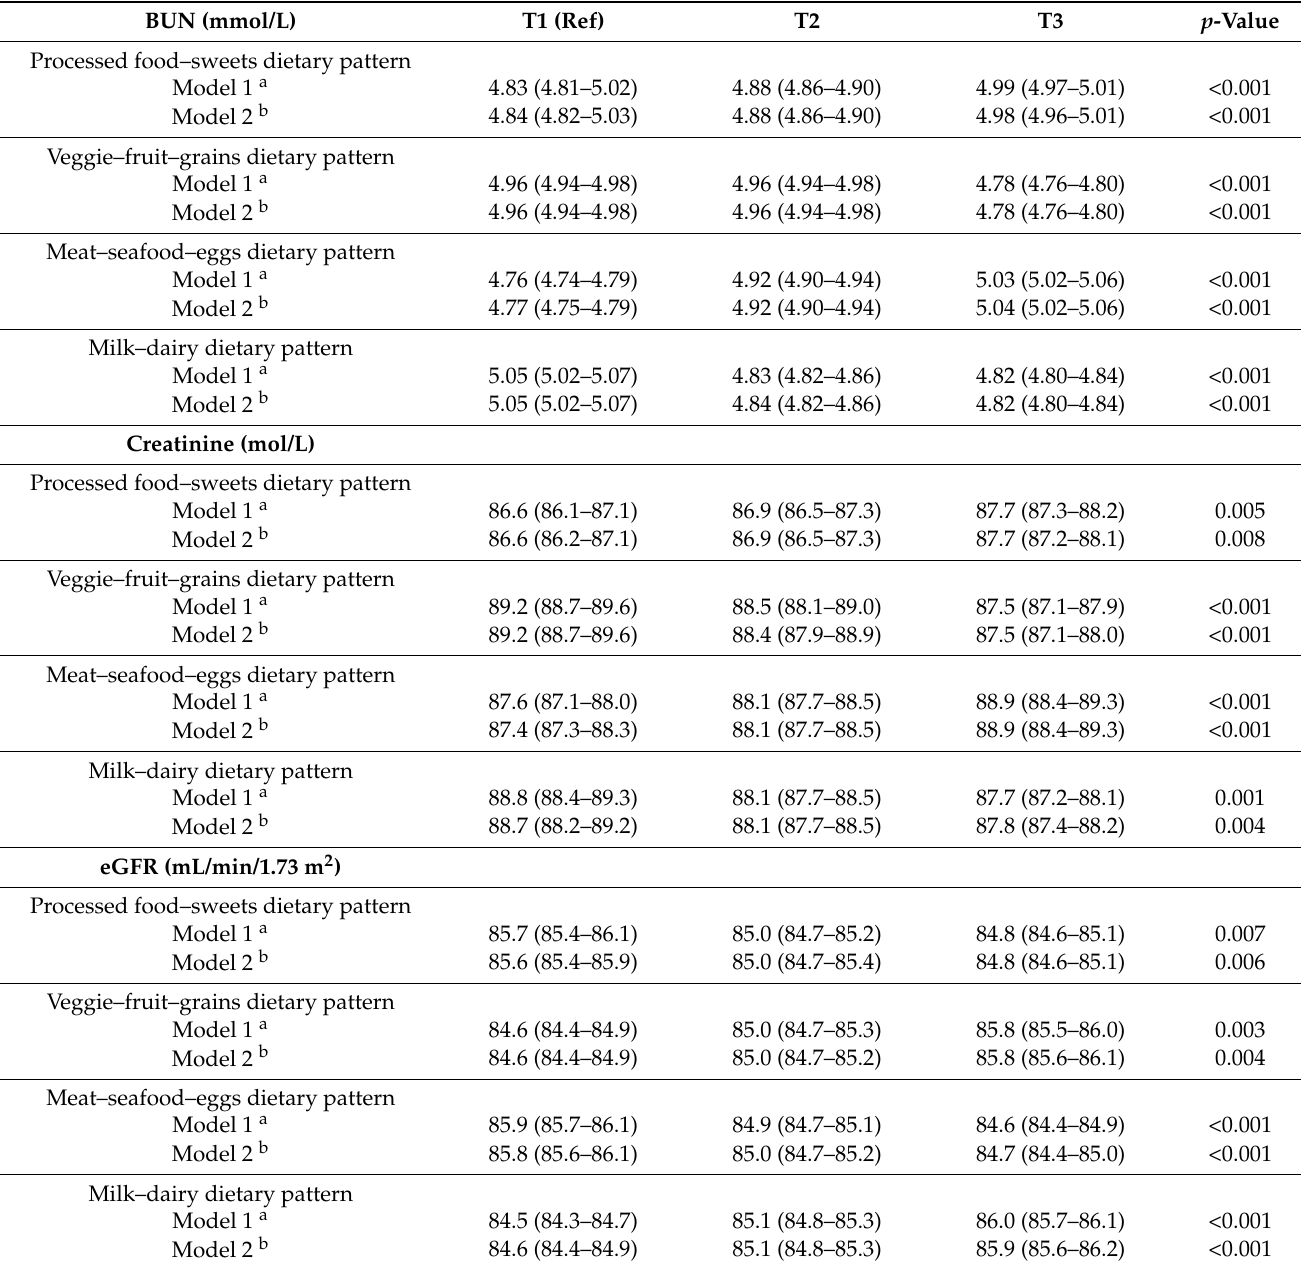
Table 7 explores the multivariable-adjusted means of BUN, creatinine, eGFR, and uric acid as parameters of kidney function across tertiles of dietary patterns. Higher consump- tion of the processed food–sweets dietary pattern or the meat–seafood–eggs dietary pattern was positively associated with BUN, creatinine, and uric acid but negatively correlated with eGFR after adjusting for model 1 (sex, age, marital status, education, current smoking, current drinking, and physical activity) and model 2 (model 1 and the components of metabolic syndrome) (all adjusted p < 0.05). While higher consumption of the veggie– fruit–grains dietary pattern or the milk–dairy dietary pattern was negatively associated with BUN, creatinine, and uric acid but positively correlated with eGFR after adjusting for model 1 and model 2 (all adjusted p < 0.05). Table 7. Multiple linear regression analysis of the association between dietary patterns and kidney function parameters 1 . BUN